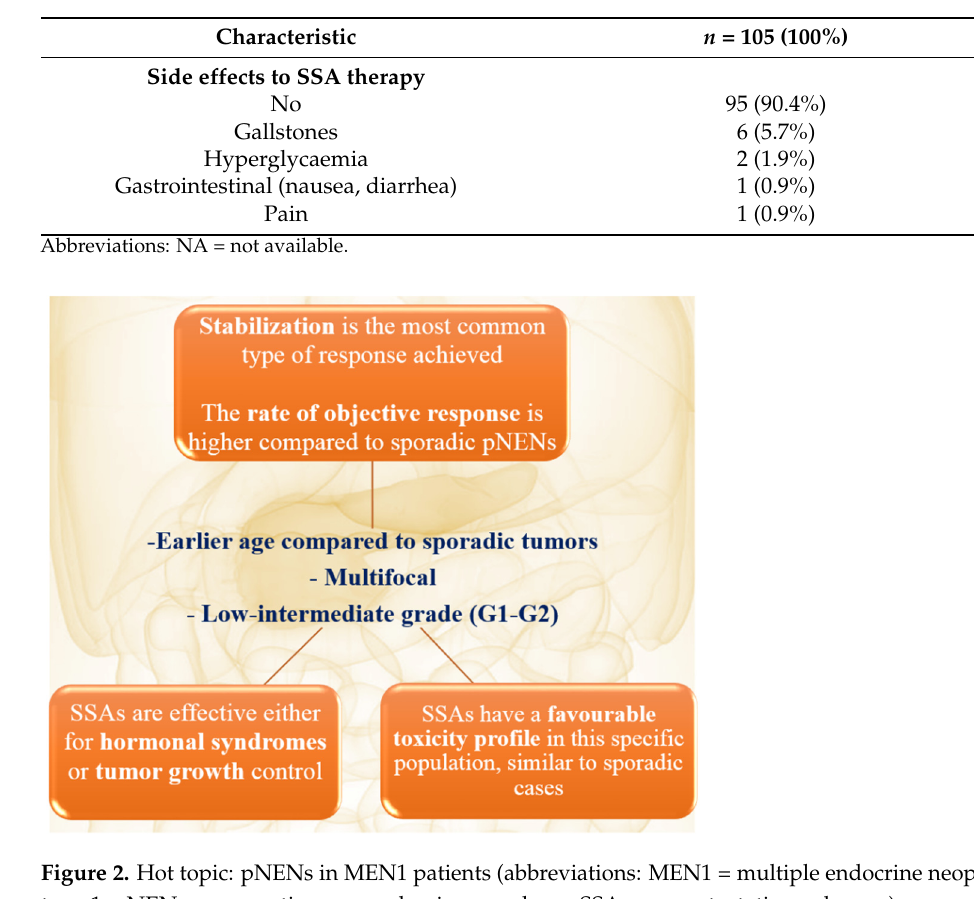
Figure 2. Hot topic: pNENs in MEN1 patients (abbreviations: MEN1 = multiple endocrine neoplasia type 1; pNEN = pancreatic neuroendocrine neoplasm; SSAs = somatostatin